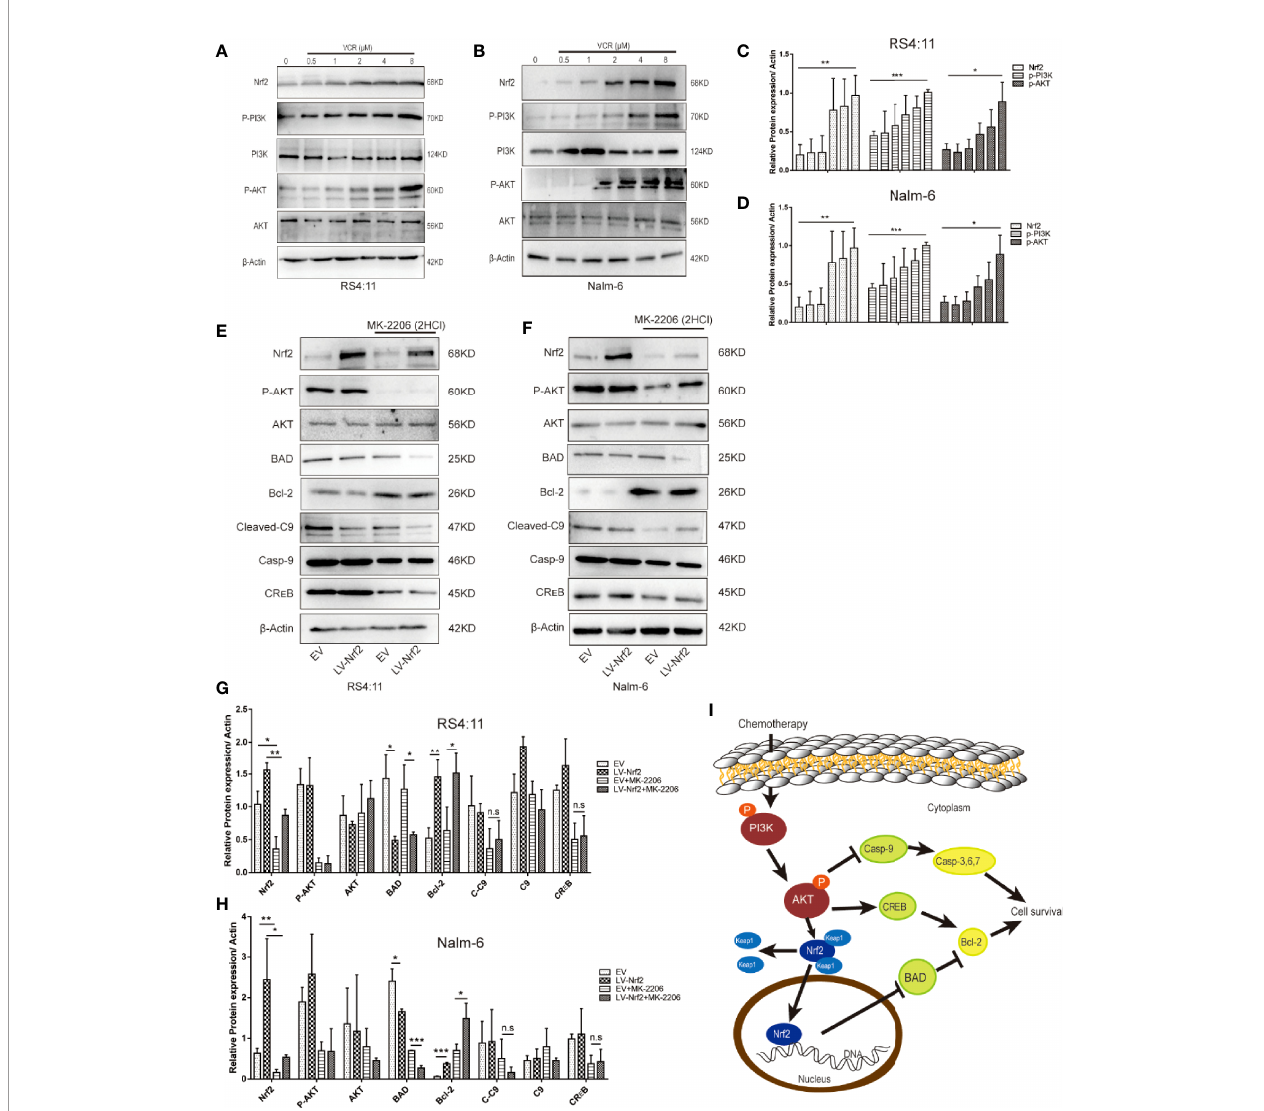
FIGURE 4 | (A) Representative western blot of Nrf2, p-PI3K, PI3K, p-AKT, AKT, and b -Actin in RS4:11 cells. The cells were pretreated with or without VCR (0.5,1,2,4 and 8 m M, 24 h). (B) Representative western blot of Nrf2, p-PI3K, PI3K, p-AKT, AKT, and b -Actin in Nalm-6 cells. The cells were pretreated with or without VCR (0.5,1,2,4 and 8 m M, 24 h). (C, D) The relative grey values were shown in the histogram. (E) After treatment with or without 10 m M MK2206 for 24 h in RS4:11 cells, protein expression levels of Nrf2, p-AKT, AKT, BAD, Bcl-2, Caspase-9, Cleaved-Caspase9 and CR E B was evaluated by western blot analysis in the Nrf2- overexpression and EV groups. (F) After treatment with or without 10 m M MK2206 for 24 h in Nalm-6 cells, protein expression levels of Nrf2, p-AKT, AKT, BAD, Bcl- 2, Caspase-9, Cleaved-Caspase9 and CR E B was evaluated by western blot analysis in the Nrf2-overexpression and EV groups. (G, H) The relative gray values were shown in histogram. Data are presented as the mean ± SD of three independent experiments. *P < 0.05, **P < 0.01, ***P < 0.001, n.s, no signi fi cance. (I) Schematic representation of the molecular mechanisms proposed in the positive effect of regulate via Nrf2 of PI3K/Akt/Nrf2 signaling pathway in ALL